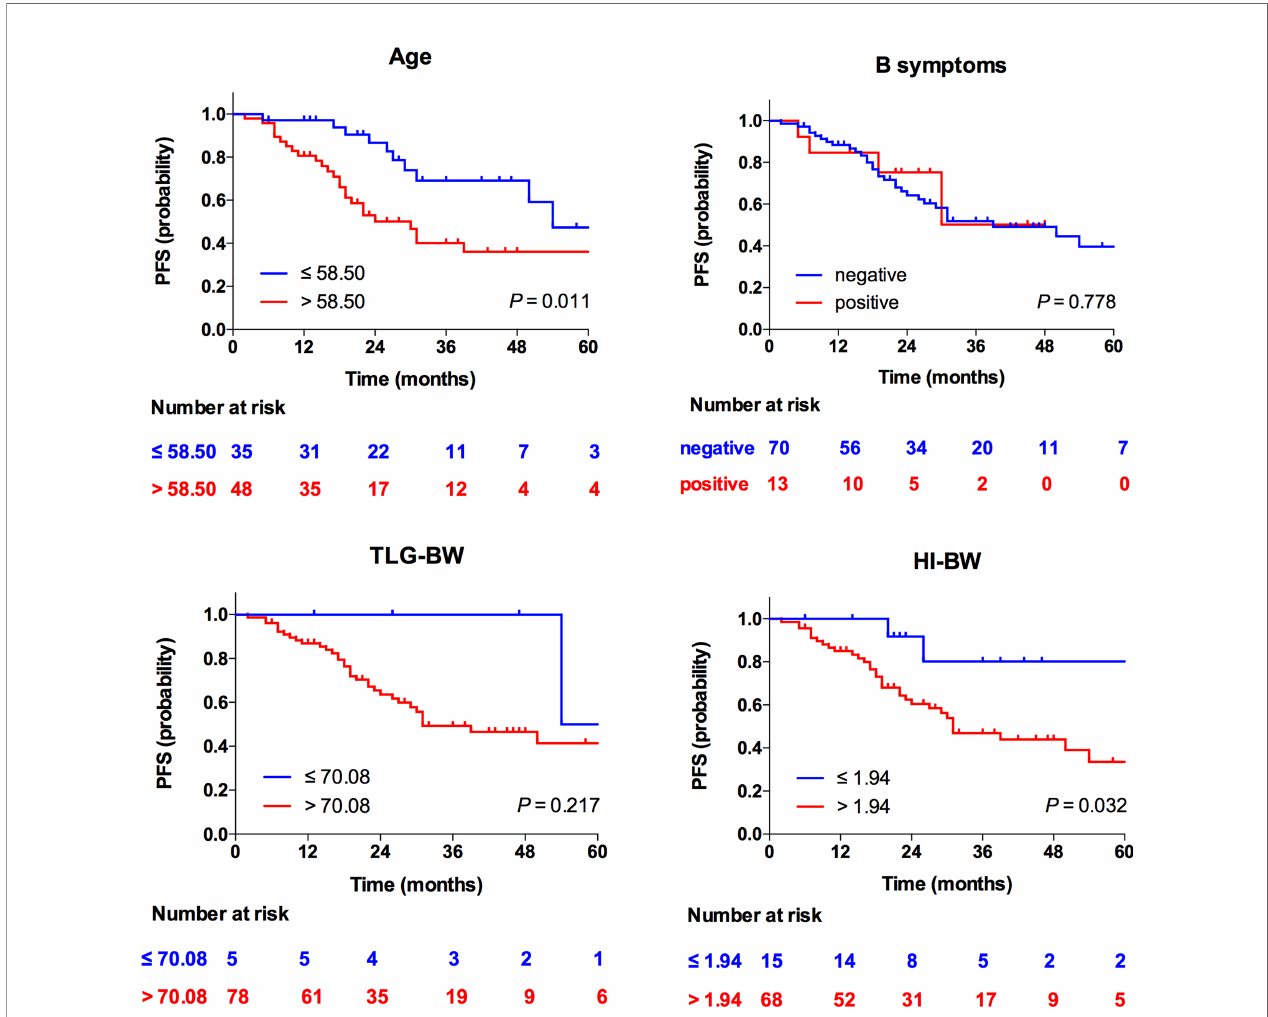
FIGURE 2 | Kaplan – Meier curves for PFS according to age, B symptoms, TLG-BW, and